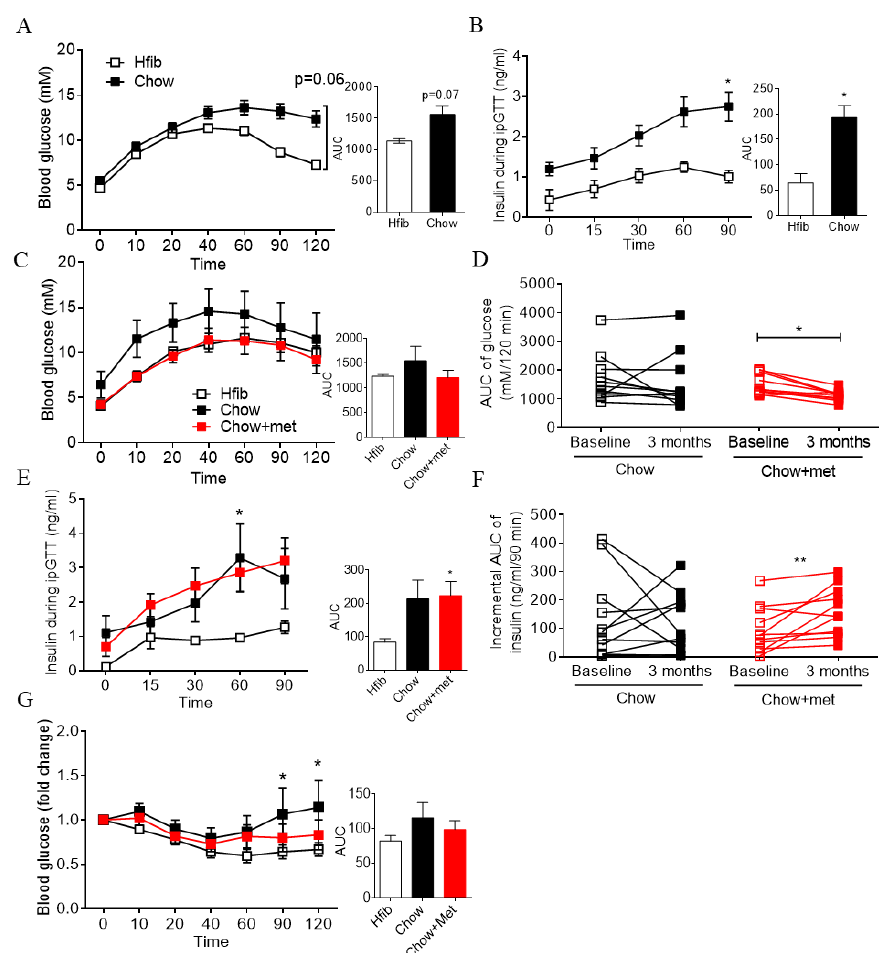
Figure 1. Glucose tolerance and insulin secretion was improved by metformin in prediabetes. ( A – F ): blood glucose ( A , C ) and insulin secretion ( B , F ) in ipGTT at baseline six weeks ( A , B ) or after treatment at three months ( C – F ); ( D , F ): comparisons of the area under the curve (AUC) of glucose ( D ) or insulin secretion ( F ) before and after treatment. ( G ): percentage change in blood glucose during ITT at three months. AUC data are presented as mean + SEM. n = 5 in Hfib; 11 in Chow and Chow + met group. For ipGTT, * p < 0.05 vs Hfib, ** p < 0.01 vs Hfib, # p < 0.05 Chow vs Chow + met using two-way ANOVA or Kruskal–Wallis test (AUC) followed by post hoc multiple comparison tests. For comparison of AUC before and after treatment, * p < 0.05, ** p < 0.01 using Wilcoxon matched-pairs signed-rank test.